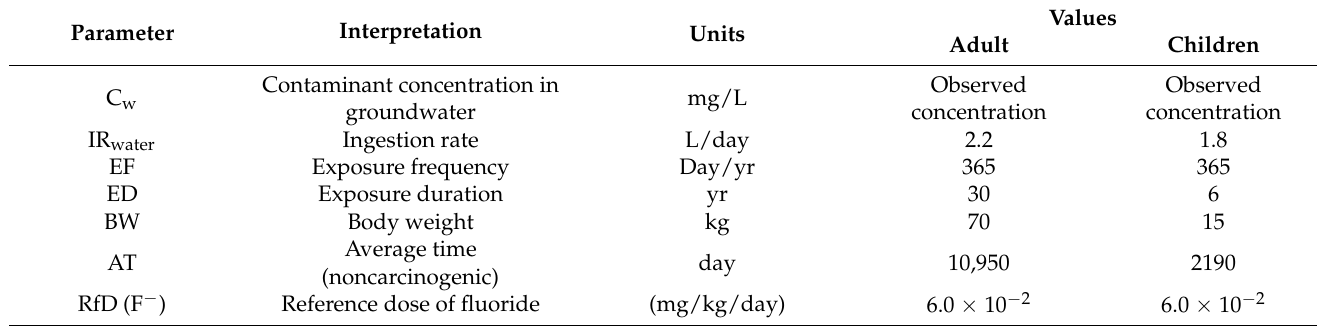
Table 2. Parameters used to calculate the chronic daily intake (CDI) (mg/kg/day) and the hazard quotient (HQ) of fluoride for adults and